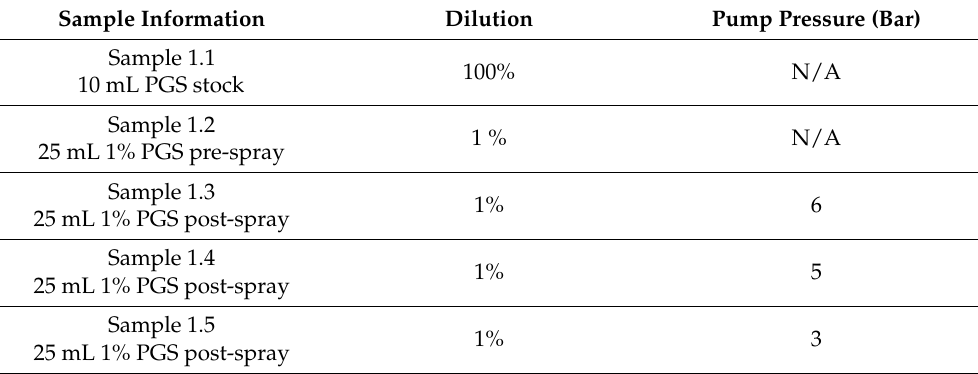
Table 2. Summary of sample plan repeated in triplicate for 1% PGS (PBW) outputs through the spray